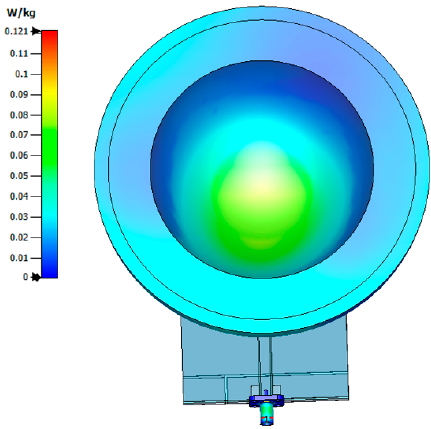
Figure 12. MBRU antenna bending analysis (at 4V varactor tuning condition).